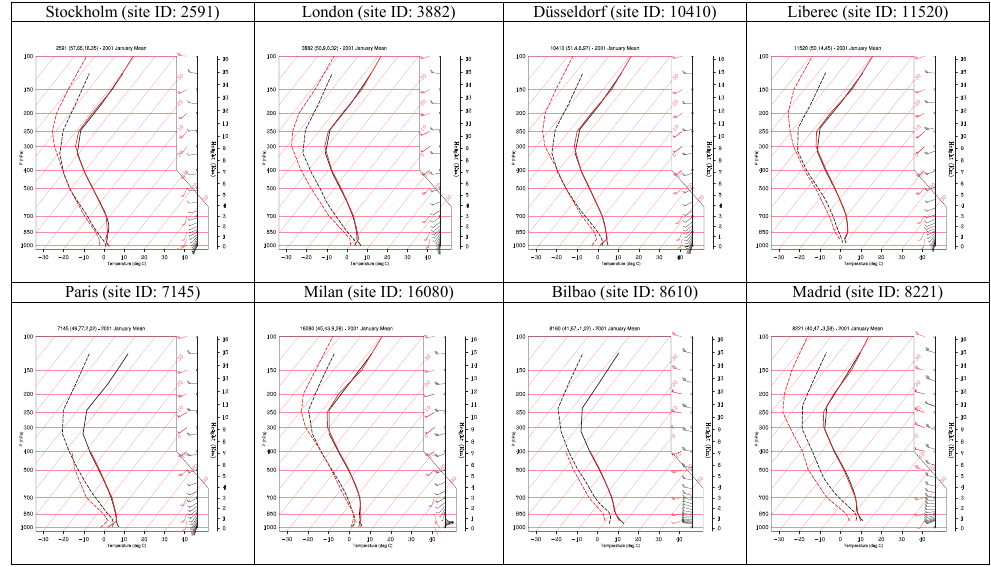
Figure 18. Monthly mean observed and simulated skew-T plots of temperature (red solid and black solid lines, respectively), dew point temperature (red dash and black dash lines, respectively), and wind speed and direction (red and black staffs and attached barbs, respectively, with a triangle, a long barb, and a short barb perpendicular to the overall staff representing 50, 10, and 5 knots, respectively) at eight stations over D01 in January, 2001.